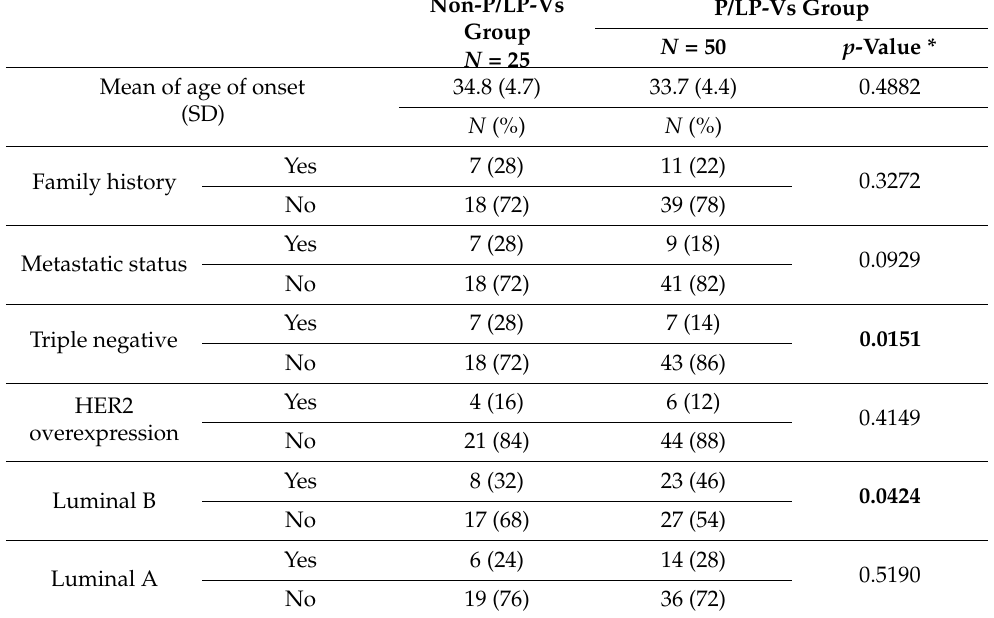
Table 3. Cancer characteristics of breast cancer patients and their correlation with pathogenic and likely pathogenic variants (P/LP-Vs) ( N =